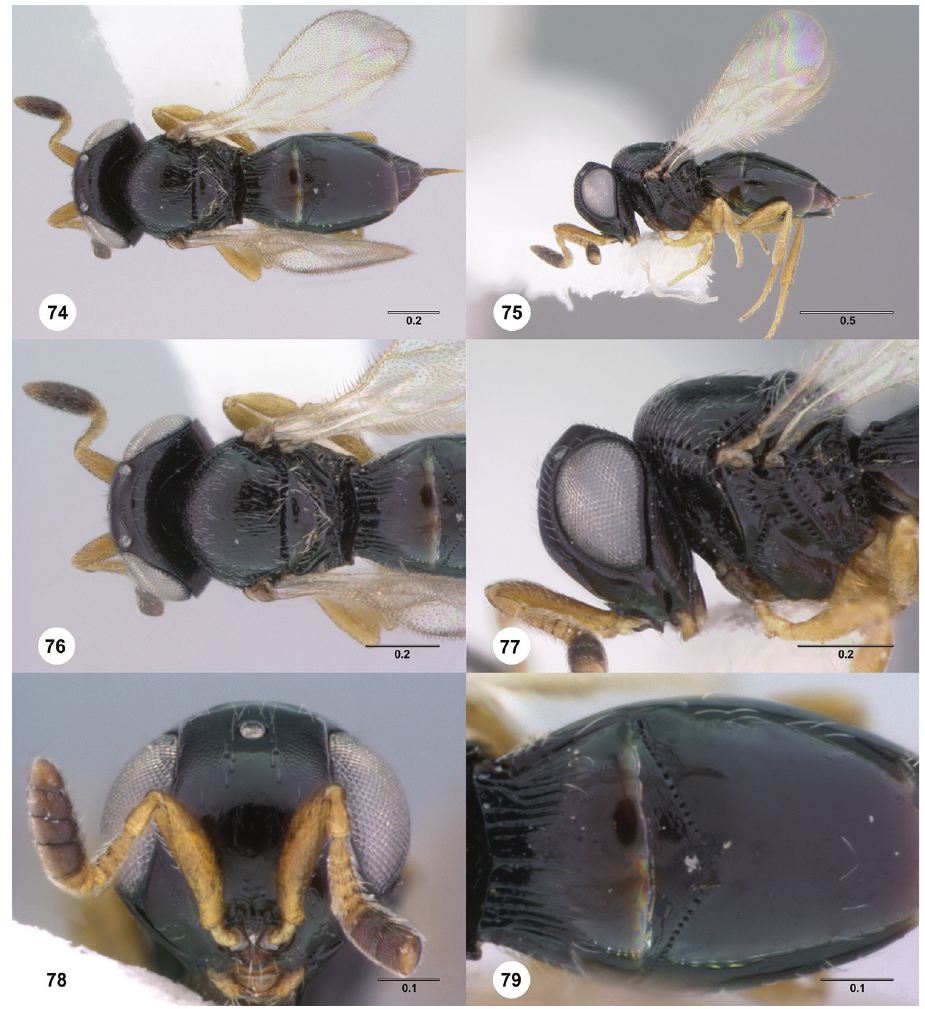
Figures 74–79. Phanuromyia princeps ♀ (OSUC 151126), 74 Dorsal habitus 75 Lateral habitus 76 Head, mesosoma, dorsal view 77 Head, mesosoma, lateral view 78 Head, mouthparts, anteroventral view 79 T1–T3, dorsal view. Scale bar in Sculpture on posterior half of mesoscutum: coriaceous to rugulose, at most with fine irregular longitudinal sculpture. Sculpture of anterior half of mesoscutellum: ru- gose-punctate. Thin median foliaceous lamella on propodeum: absent. Color of coxae: bright yellow, concolorous with legs. T1: flat, at most slightly swollen. Anterior margin of T2: medially without costae or foveolae. T2 sculpture: with transverse series of small punctures in shape of incurved chevron. Sculpture of T1: evenly costate across anterior 1/3 to 1/2, smooth in remain-